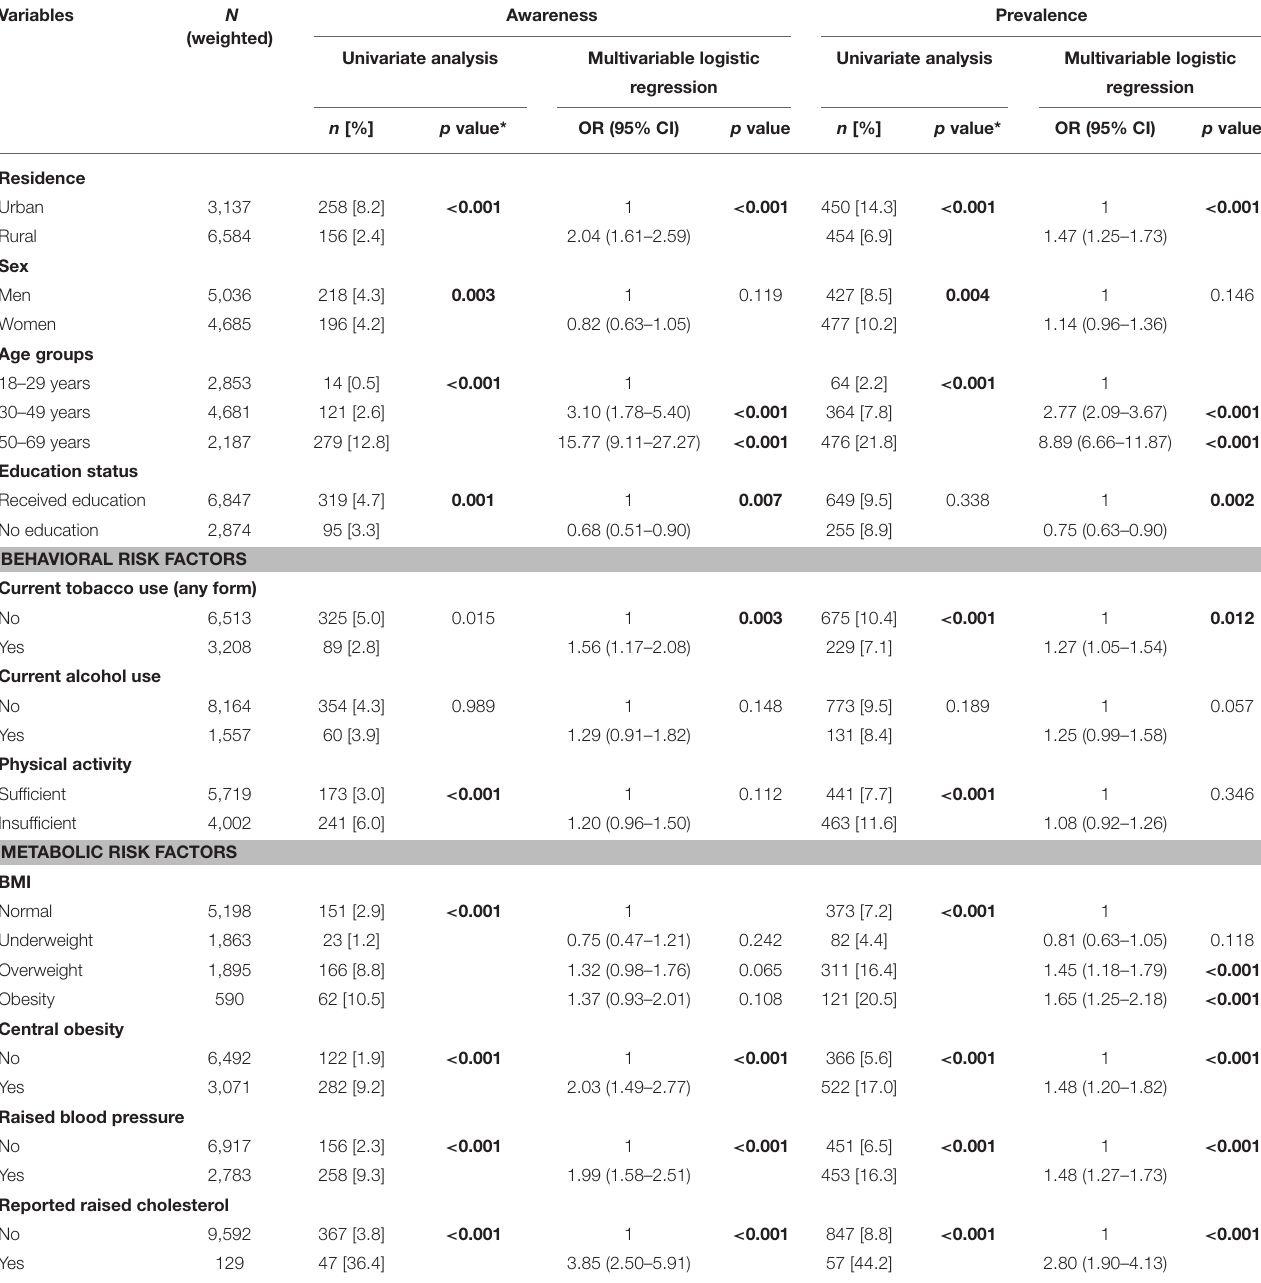
TABLE 2 | Determinants (adjusted OR) of awareness and prevalence of diabetes among adults aged 18–69 years in India. Variables N Awareness Prevalence (weighted) Univariate analysis Multivariable logistic Univariate analysis Multivariable logistic regression